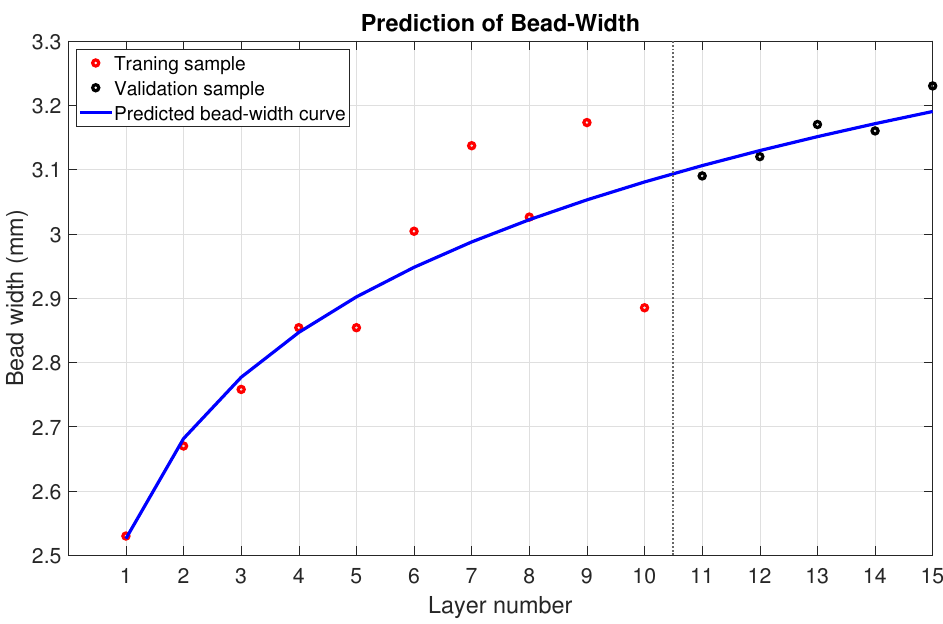
Figure 9. Result of the bead width prediction.